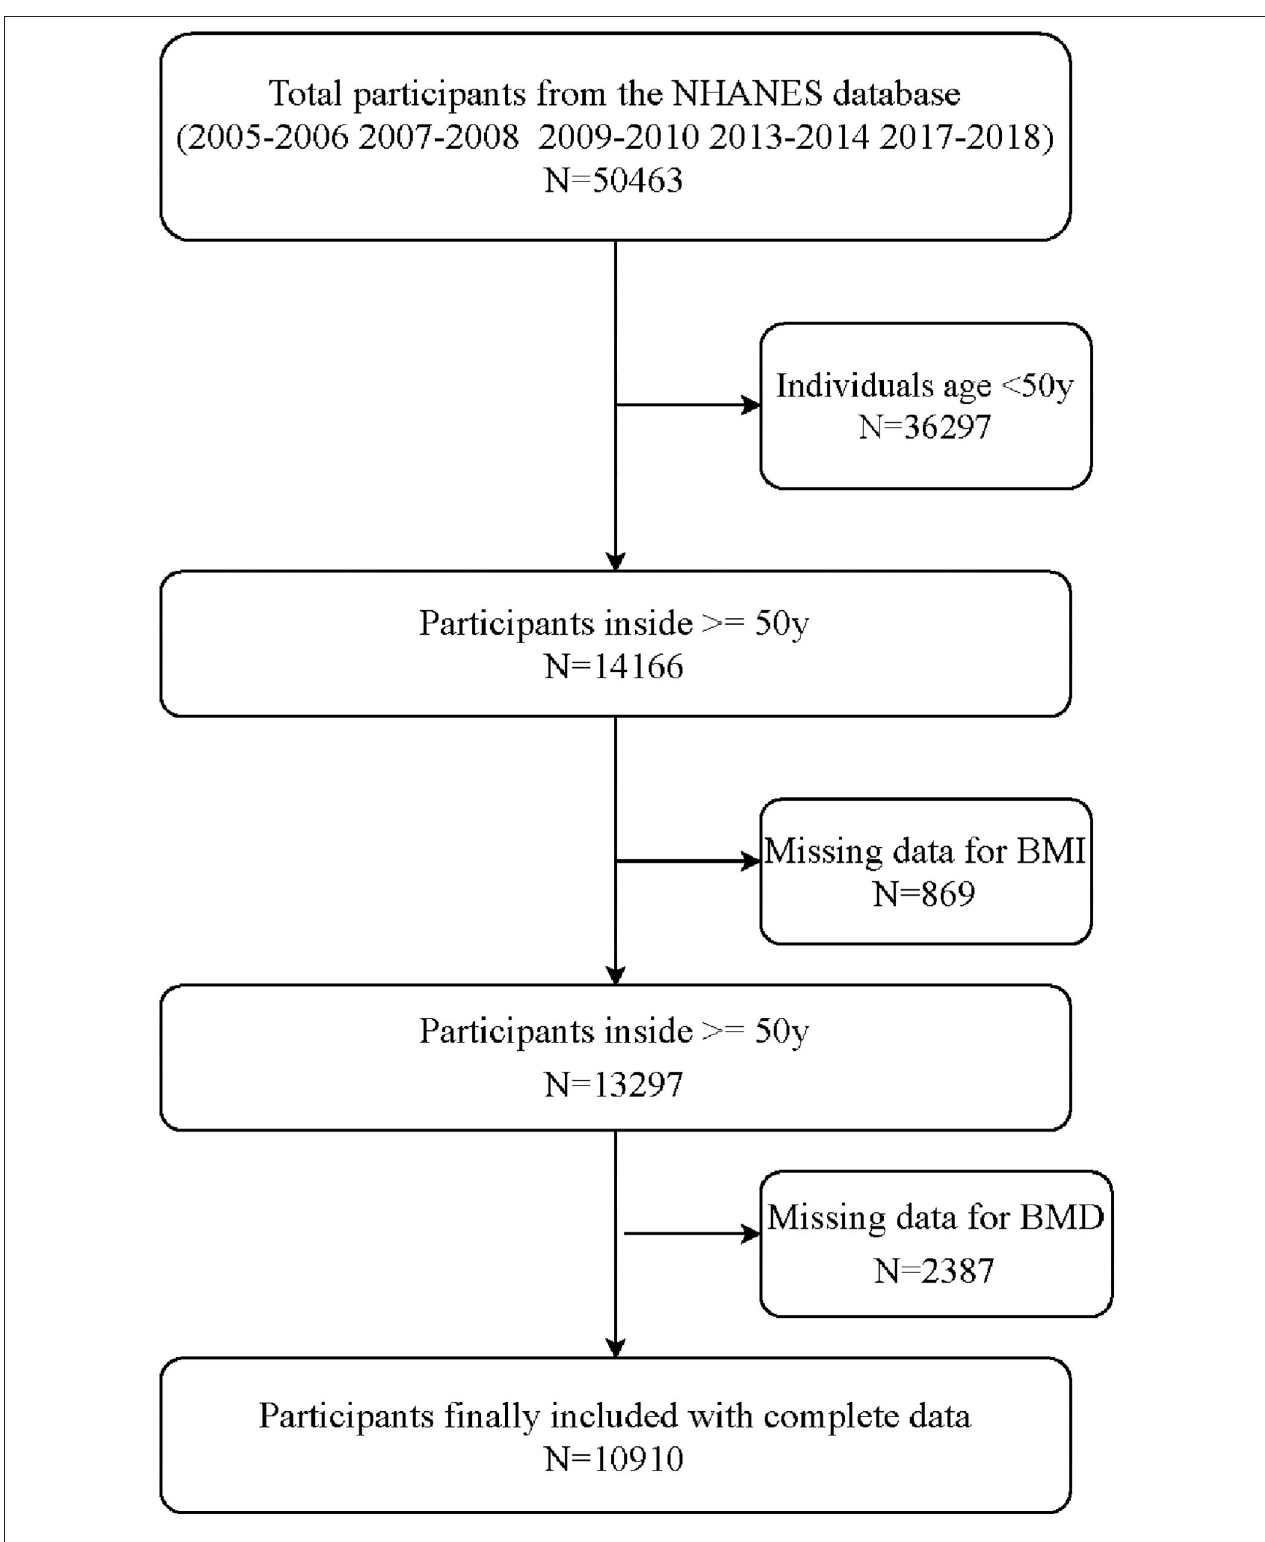
FIGURE 1 | Flow chart of participants selected from the NHANES database.